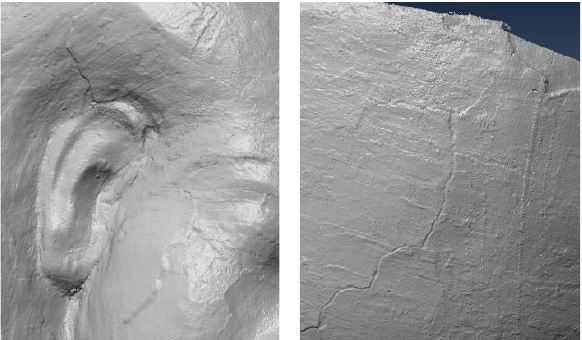
Figure 9. Two details of the mesh